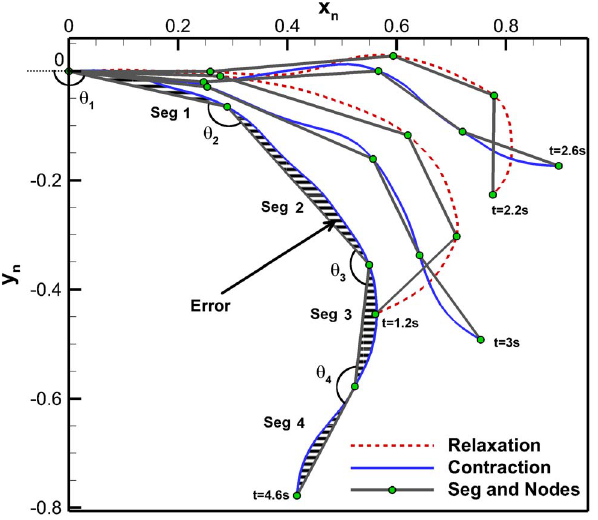
Fig. 5. Four-segment model and exumbrella profiles. The four-segment optimized model is overlaid on selected C. capillata exumbrella profiles. The time at which each profile occurs from the beginning of the relaxation phase are labeled. The segments and angles formed between each segment are also labeled. The striped area shows the error between one exumbrella profile and corresponding